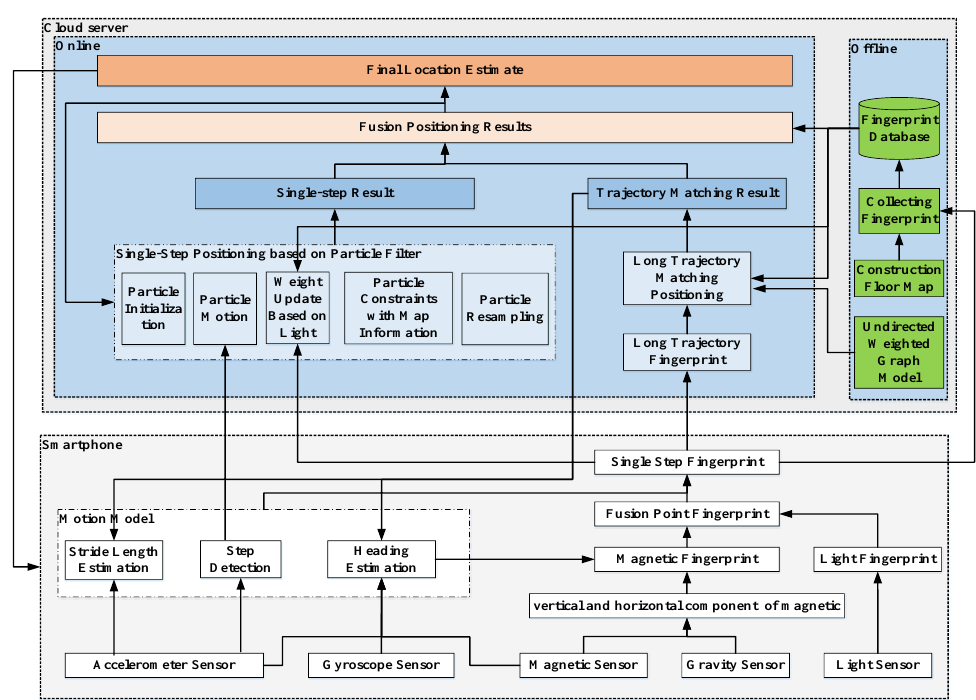
Figure 8. The architecture of LiMag.